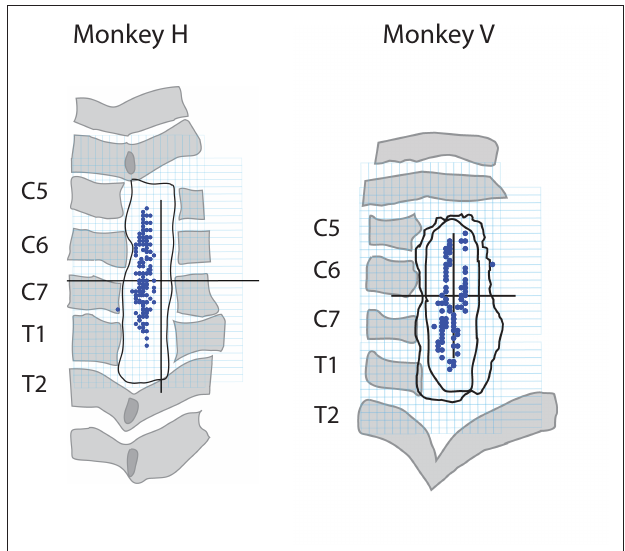
FigUre A1 | Anatomical locations of recording sites. Cross represents the (0,0) of the rostral–caudal and medial–lateral axis. Blue circles represent all recording sites (including those which were omitted after further analysis). Cervical and upper thoracic vertebrae are shown (C5–C7, T1–T2).